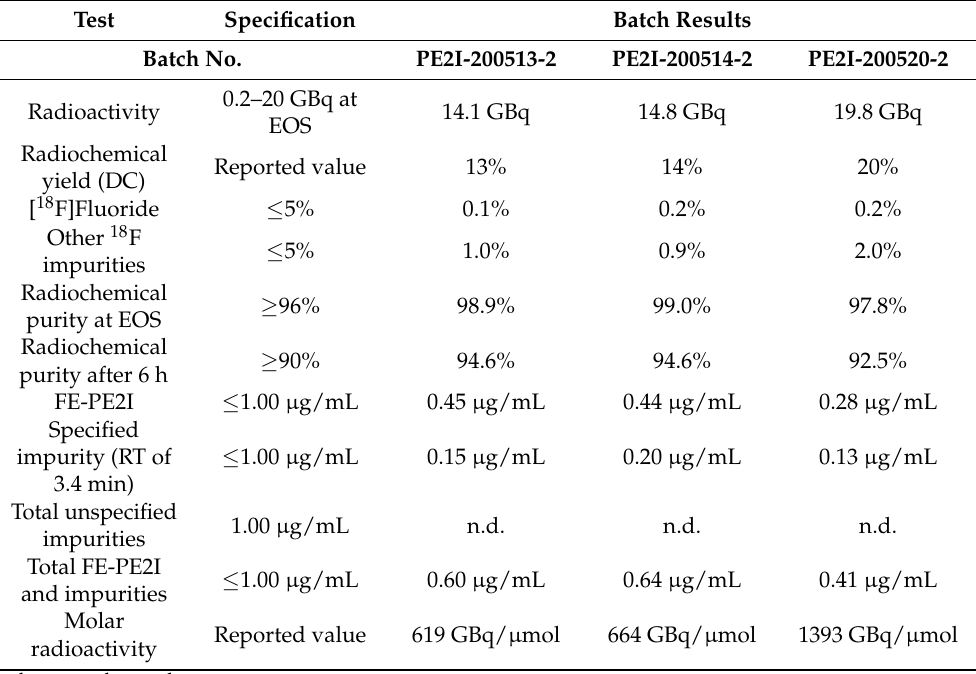
Table 2. Details for process validation of [ 18 F]FE-PE2I produced on a Synthera ® + synthesis